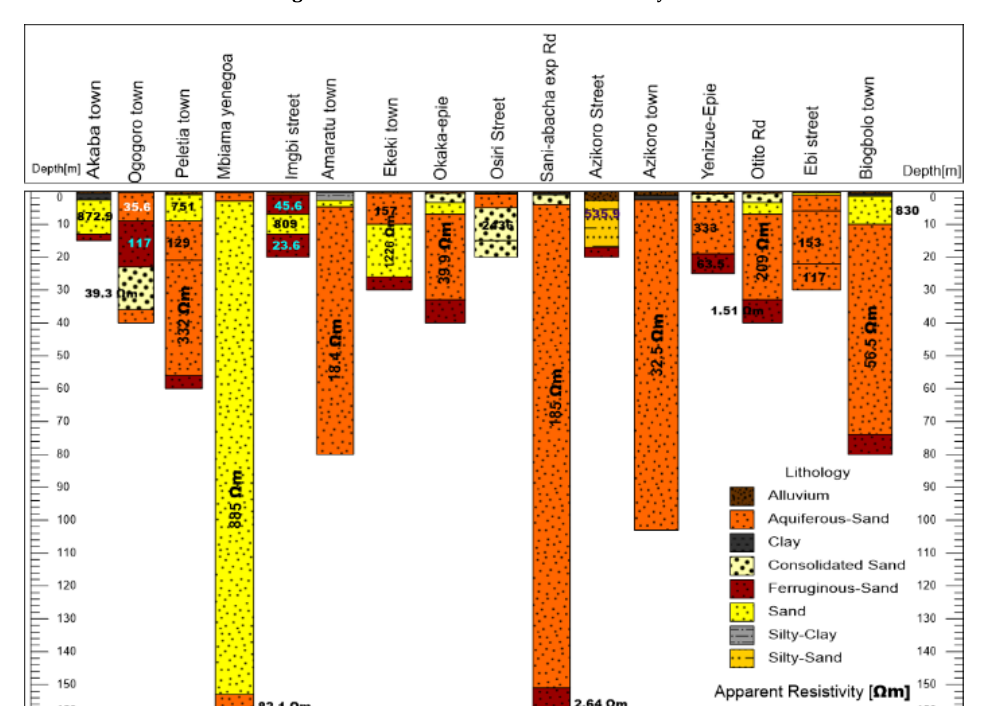
Figure 4: Geoelectric Section across the Study Area